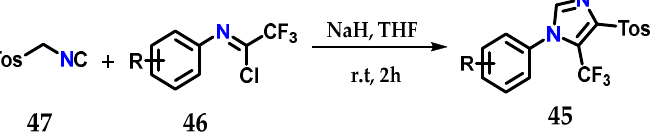
Figure 20. Obtaining 1,4,5-trisubstituted imidazoles 45 using the Van Leusen method.